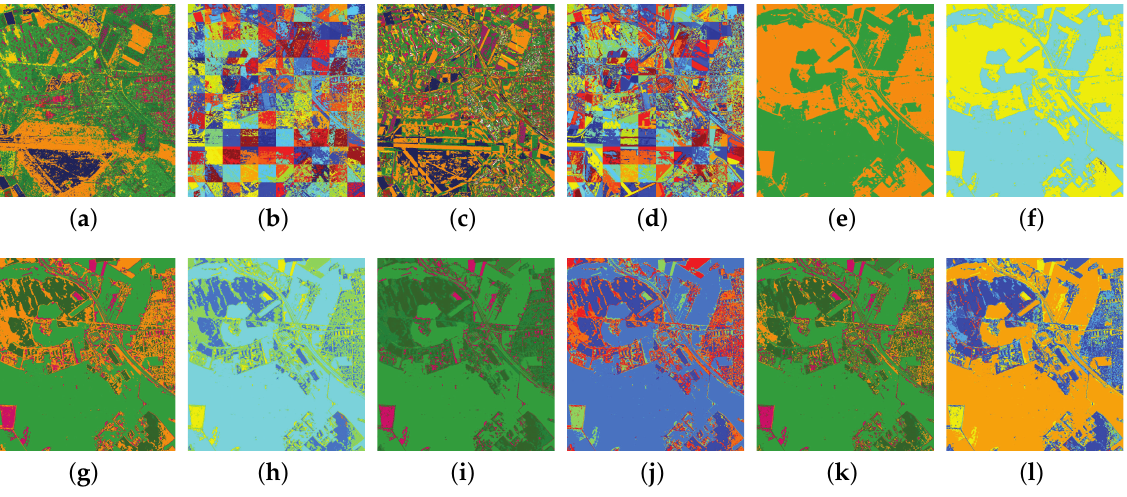
Figure A1. Classification results of Oberpfaffenhofen with different class numbers. ( a ) Initial results with PCST. ( b ) Initial results with “label2rgb”. ( c ) Result after optimization with PCST. ( d ) Result after optimization with “label2rgb”. ( e ) Result of 3 classes with PCST. ( f ) Result of 3 classes with “label2rgb”. ( g ) Result of 5 classes with PCST. ( h ) Result of 5 classes with “label2rgb”. ( i ) Result of 7 classes with PCST. ( j ) Result of 7 classes with “label2rgb”. ( k ) Result of 9 classes with PCST. ( l ) Result of 9 classes with